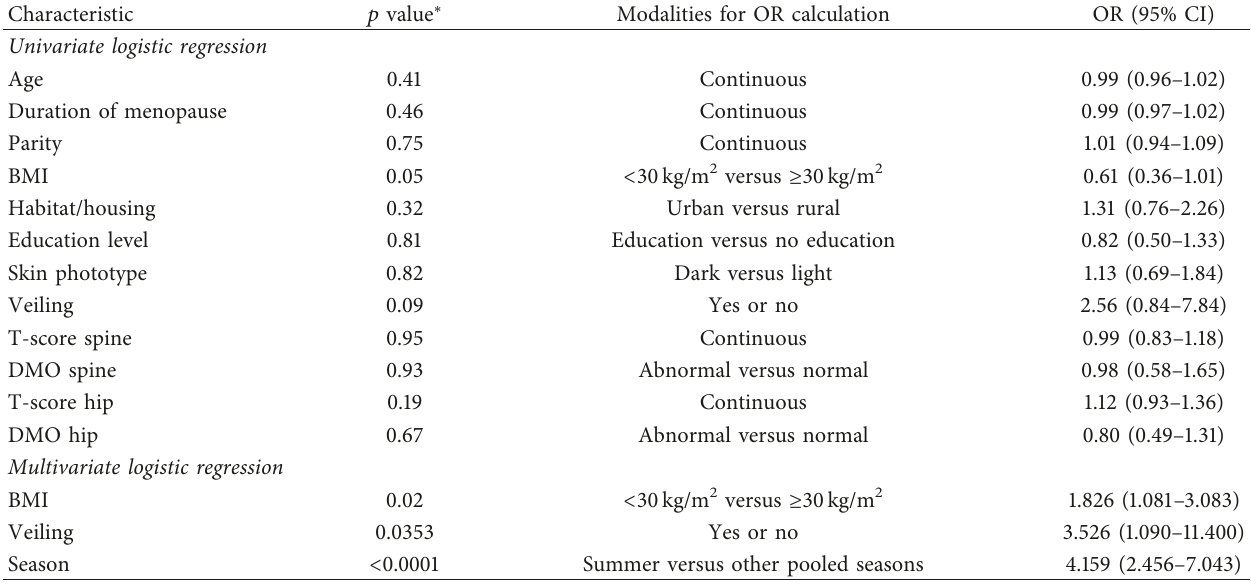
Table 2: Results of the univariate and multivariate logistic regression models for the association of subject characteristics with vitamin D hypovitaminosis with the cutoff value of 17ng/mL ∗